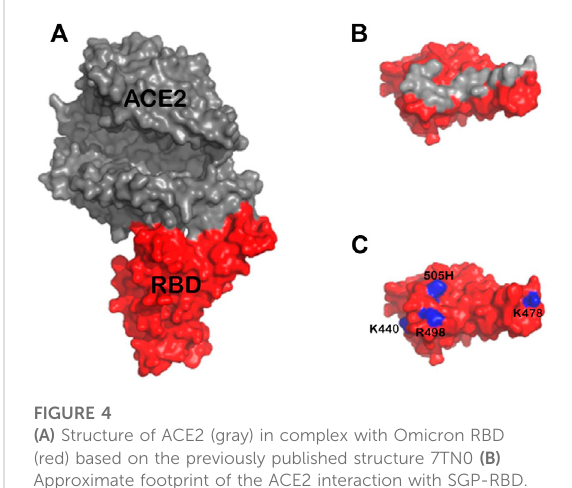
FIGURE 4 (A) Structure of ACE2 (gray) in complex with Omicron RBD (red) based on the previously published structure 7TN0 (B) Approximate footprint of the ACE2 interaction with SGP-RBD. ACE2 was removed from the image and the SGP-RBD was rotate 60 ° . Gray RBD residues are located within fi ve angstroms of ACE2 in the bound structure (C) Residues 440K, 478K, 498R, and 505H are shown in blue. The Q493K mutation was not present in this